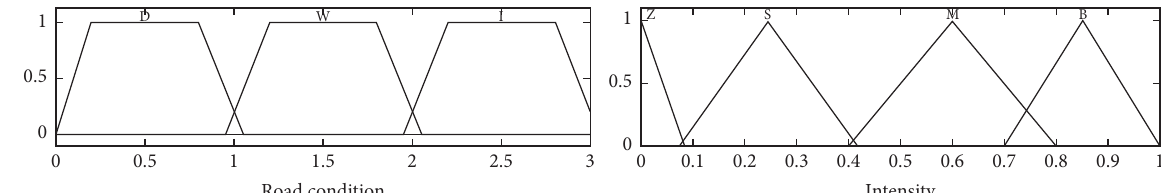
Figure 6: The membership function about the road condition and braking intensity.